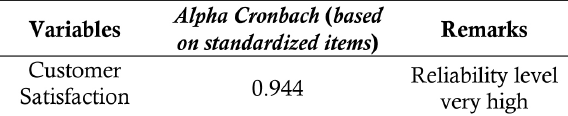
Figure 1. Patient’s Education Level